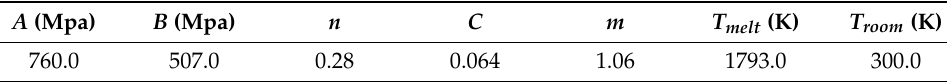
Table 3. Parameters in the strength model of steel